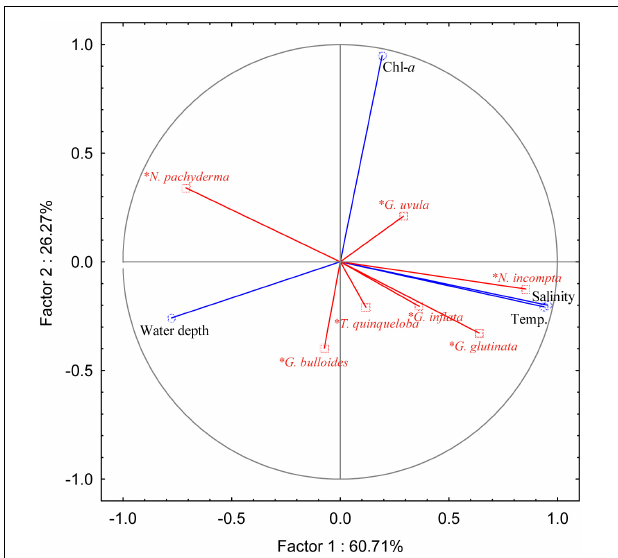
FIGURE 6 | Principal component analysis (PCA) plot of the relative abundance of the different species ( N . pachyderma : Neogloboquadrina pachyderma ; N . incompta : Neogloboquadrina incompta; G . inflata : Globorotalia inflata; G . glutinata : Globigerinita glutinata ; G . bulloides : Globigerina bulloides ; T . quinqueloba : Turborotalita quinqueloba ; G . uvula : Globigerinita uvula ) with different environmental parameters [average temperature (Temp., ◦ C) and salinity (PSU) of the first 100 m of the water column, Chlorophyll- a concentration (Chl- a , mg m - 3 ) and water depth